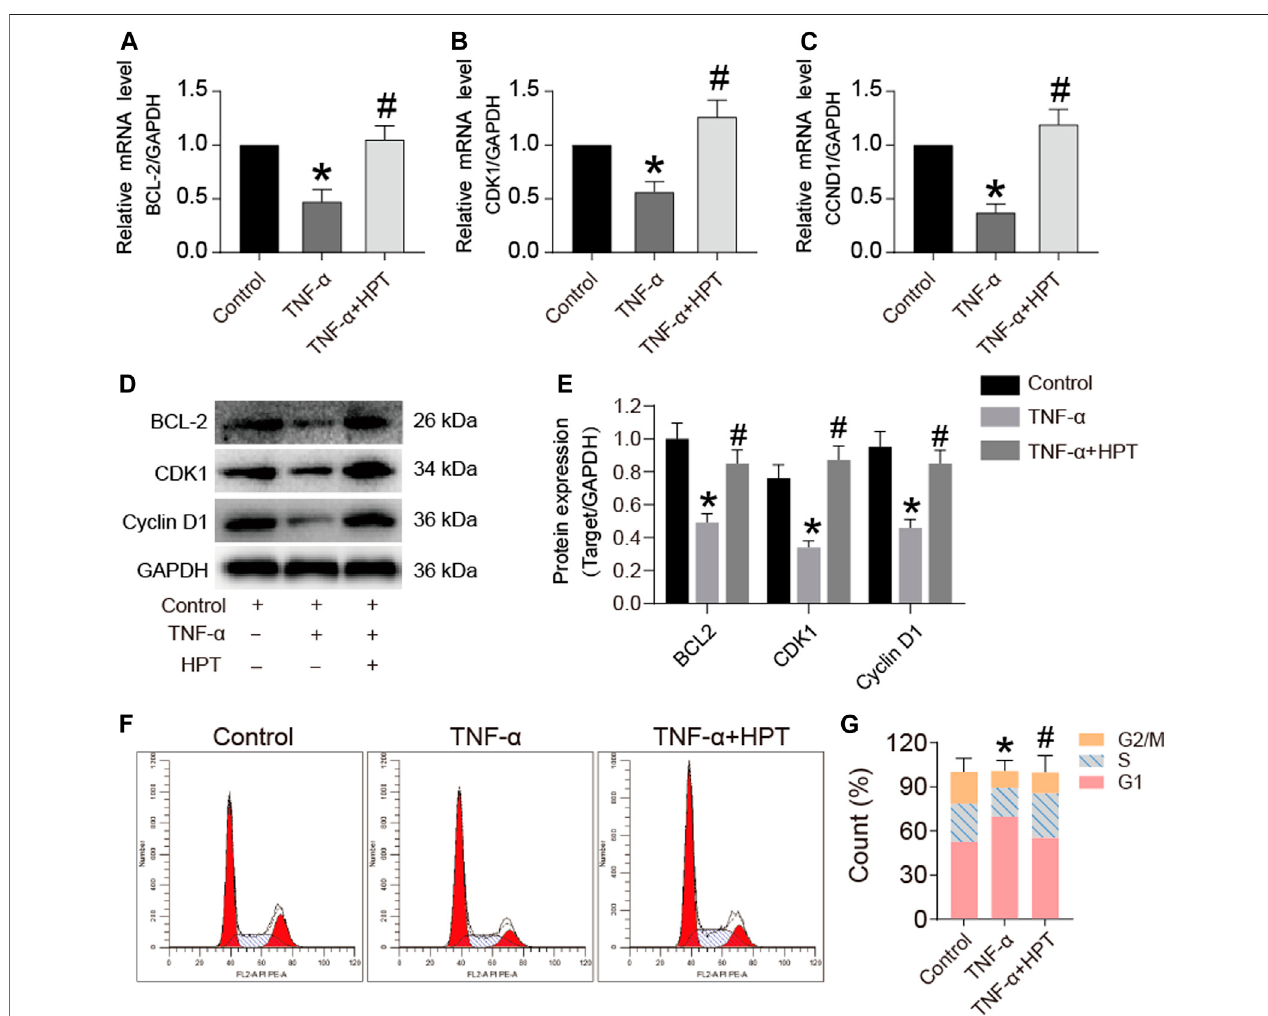
FIGURE 3 | The effect of HPT on the cell cycle of chondrocytes induced by TNF- α . (A – E) The expression levels of apoptosis and cycle-related genes and proteins afterstimulatedchondrocyteswithTNF- α andthentreatedthemwithorwithout10 μ MHPTfor48 h.* P < 0.05wasconsideredasasigni fi cantdifferencefromthecontrol group; # p < 0.05 wasconsidered as asigni fi cant differencefrom TNF- α . (F, G) Flow cytometry used todetect the effect ofHPT on the chondrocytes cycle. Counted the percentages of the G2/M phase, s phase, and G1 phase, make statistical comparisons. There are three replicates for each concentration point. * P < 0.05 was considered as a signi fi cant difference from the control group; # p < 0.05 was considered as a signi fi cant difference from TNF- α .